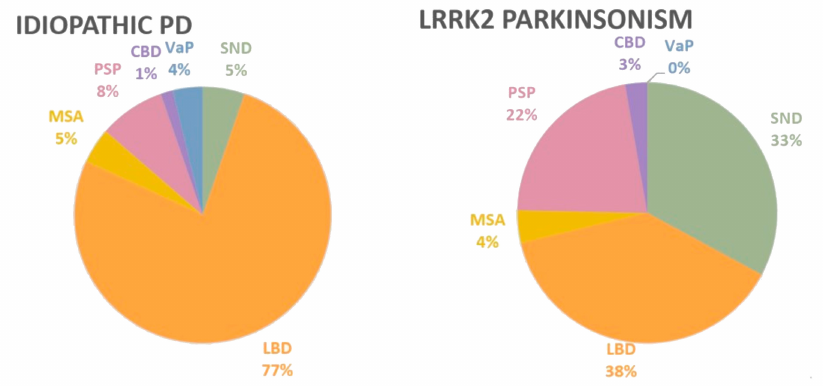
Figure 2. Frequency of neuropathologic disorders with a clinical diagnosis of idiopathic Parkinson’s disease (PD) and LRRK2 parkinsonism. The pie charts show the frequency of pathologic disorders that present with clinical parkinsonism without dementia ( n = 132), adapted from Dickson et al. (2018) [98], and LRRK2 -PD from cases and case series described in the literature ( n = 74; Table 1). Abbreviations: Lewy body disorder (LBD), multiple system atrophy (MSA), progressive supranuclear palsy (PSP), corticobasal degeneration (CBD), vascular parkinsonism (VaP), and substantia